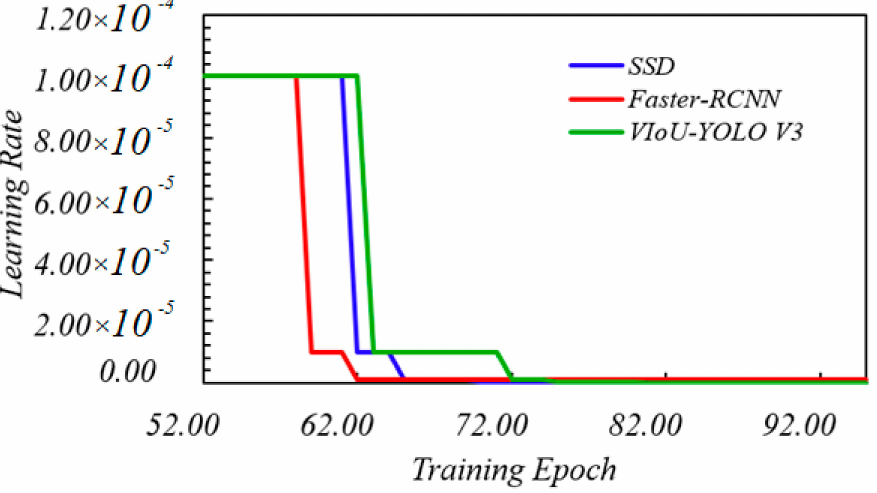
Figure 14. Learning rate versus training